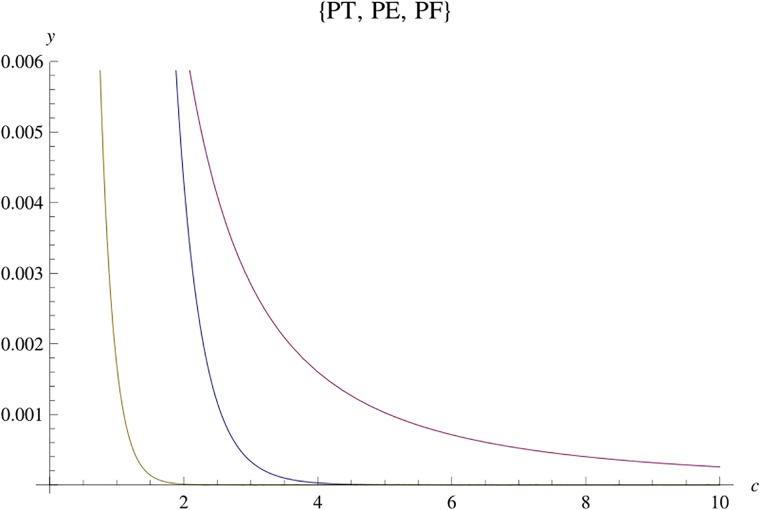
Graphs of PT, PE and PF for nT = nR = l = 2.